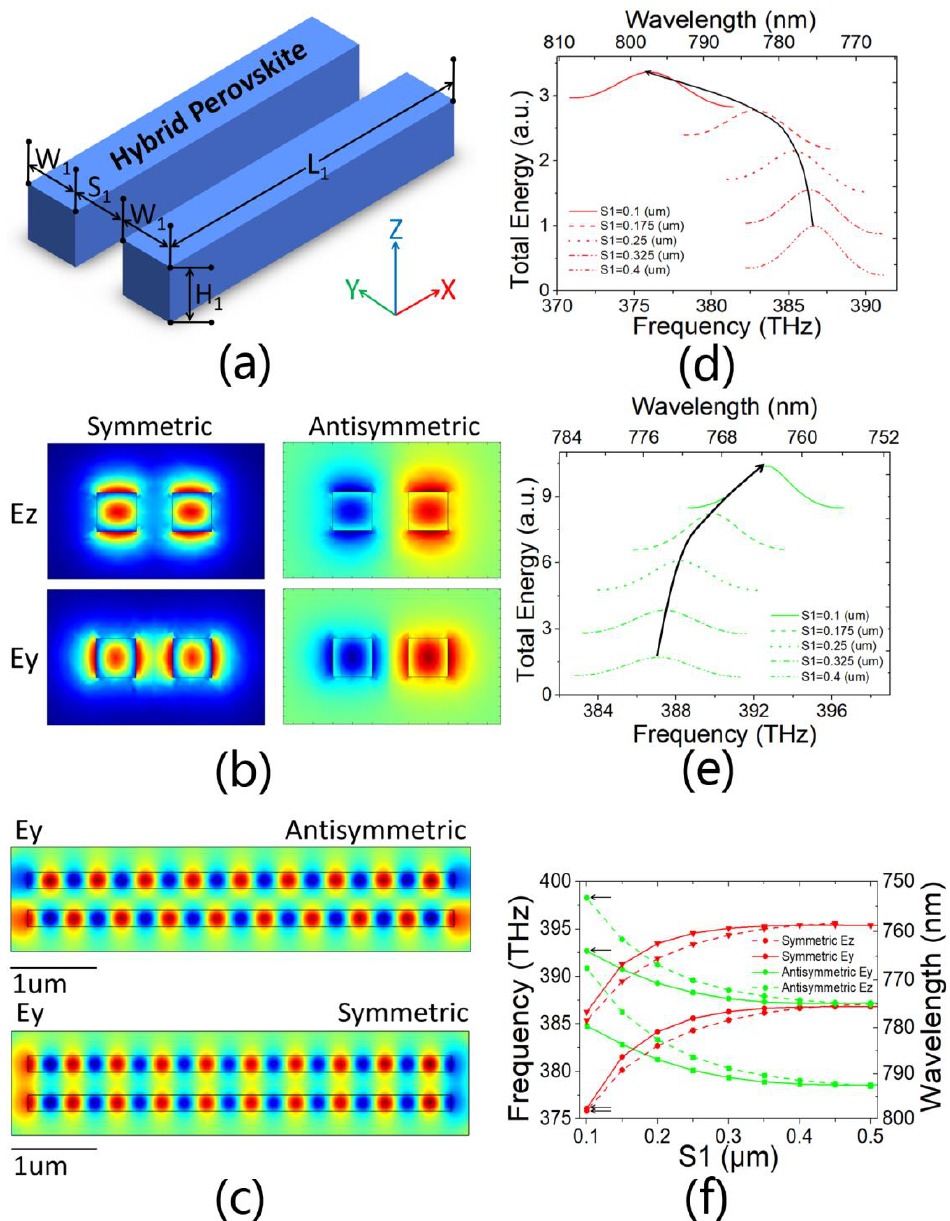
Figure 1. ( a ) Coupled photonic DNC. S 1 = 0.2 µ m. L 1 = 5 um. W 1 = H 1 = 0.2 µ m. The refractive index of semiconductor nanowire n = 2.59. The nanowires are placed in the air. ( b ) Electric field distribution at the y–z cross section of symmetric and antisymmetric modes of z and y polarizations. The z component of the E field is shown for E z modes, while the y component of the E field is shown for E y modes. ( c ) E field distribution at the x–y cross section for antisymmetric and symmetric E y modes at the middle of the nanowire. The y component of the electric field is shown here, at frequencies of 380.3 and 385.4 THz, respectively. ( d , e ) Total energy spectra of symmetric E y mode and antisymmetric E y mode, respectively, as S 1 grows smaller. ( f ) Resonant frequencies versus S 1 for symmetric and antisymmetric modes of y and z